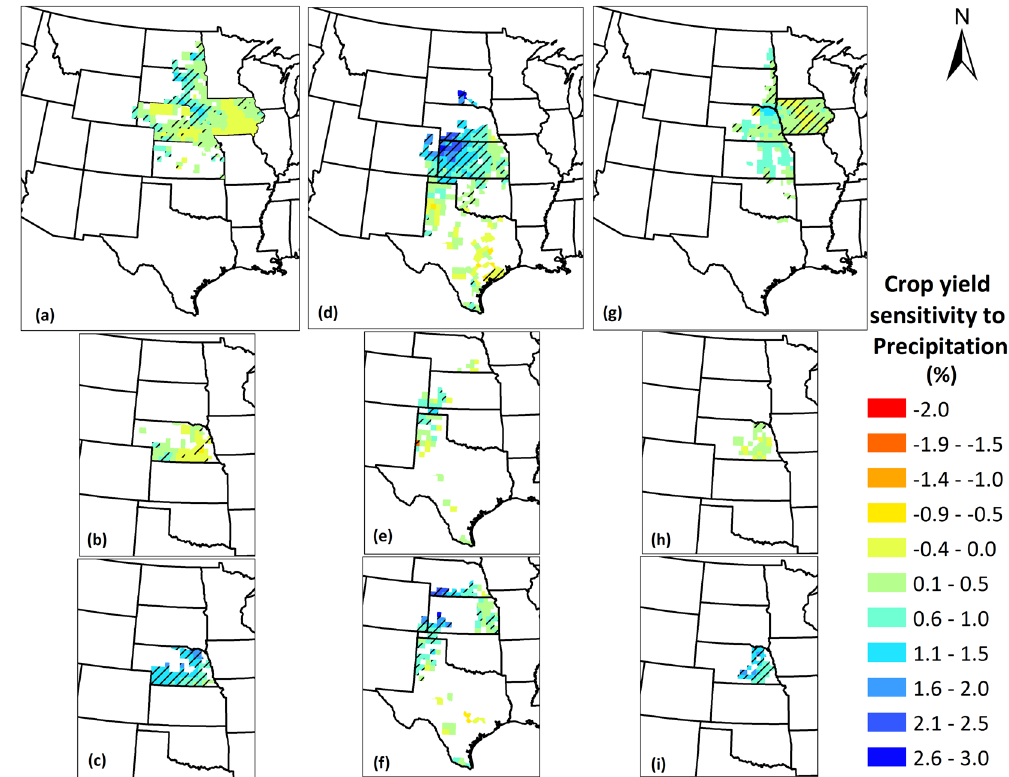
Figure 9. Crop yield sensitivity to precipitation for ( a ) Maize; ( b ) Irrigated maize; ( c ) Non-irrigated maize; ( d ) Sorghum; ( e ) Irrigated sorghum; ( f ) Non-irrigated sorghum; ( g ) Soybean; ( h ) Irrigated soybean; ( i ) Non-irrigated soybean yields in the Great Plains counties over the period 1968–2013. The value represents change in crop yields as percentage of mean crop yields over 1968–2013 per 10 mm increase in precipitation. Negative values indicate that the crop yields decrease with precipitation rise and positive values indicate that they increase with precipitation rise. Counties with striped lines indicate that the sensitivity magnitudes were statistically significant at 90% confidence level. We created the maps using ESRI ArcMap 10.4.1 software http://